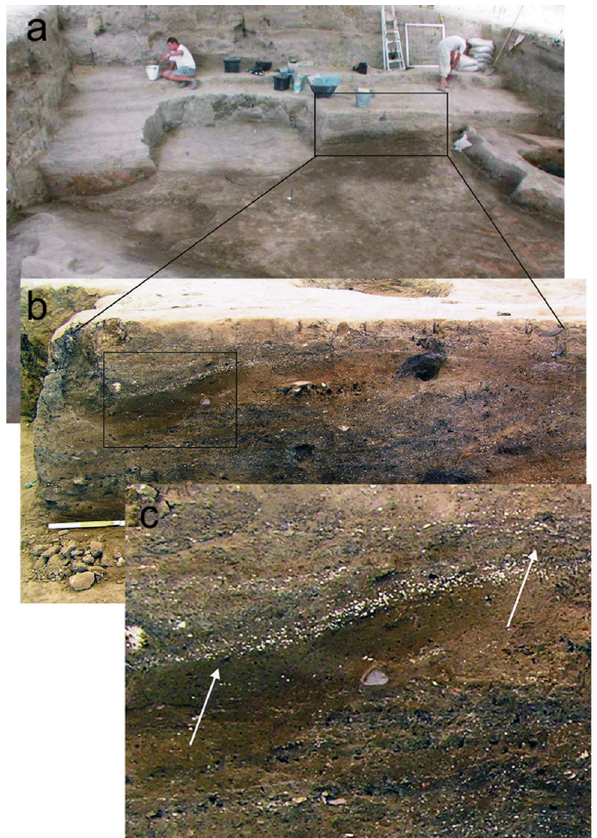
Figure 8: TP Area midden photos showing: ( a ) excavation area, ( b ) midden section studied, and ( c ) bands of gypsum nodules and lack of extensive fi ne strati fi